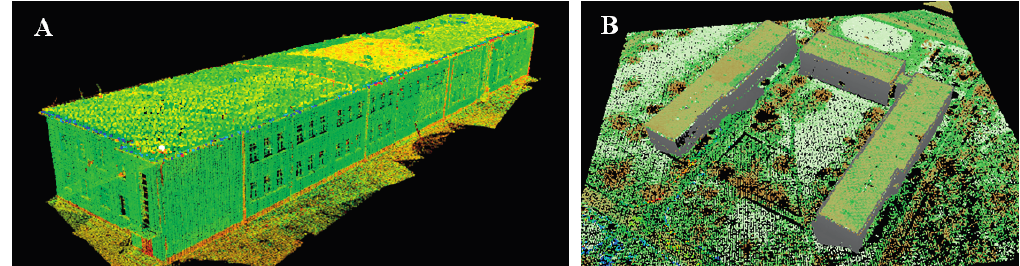
Figure 19. Integrated ALS and TLS point clouds ( A ) One separate test building; ( B ) Complex of buildings.